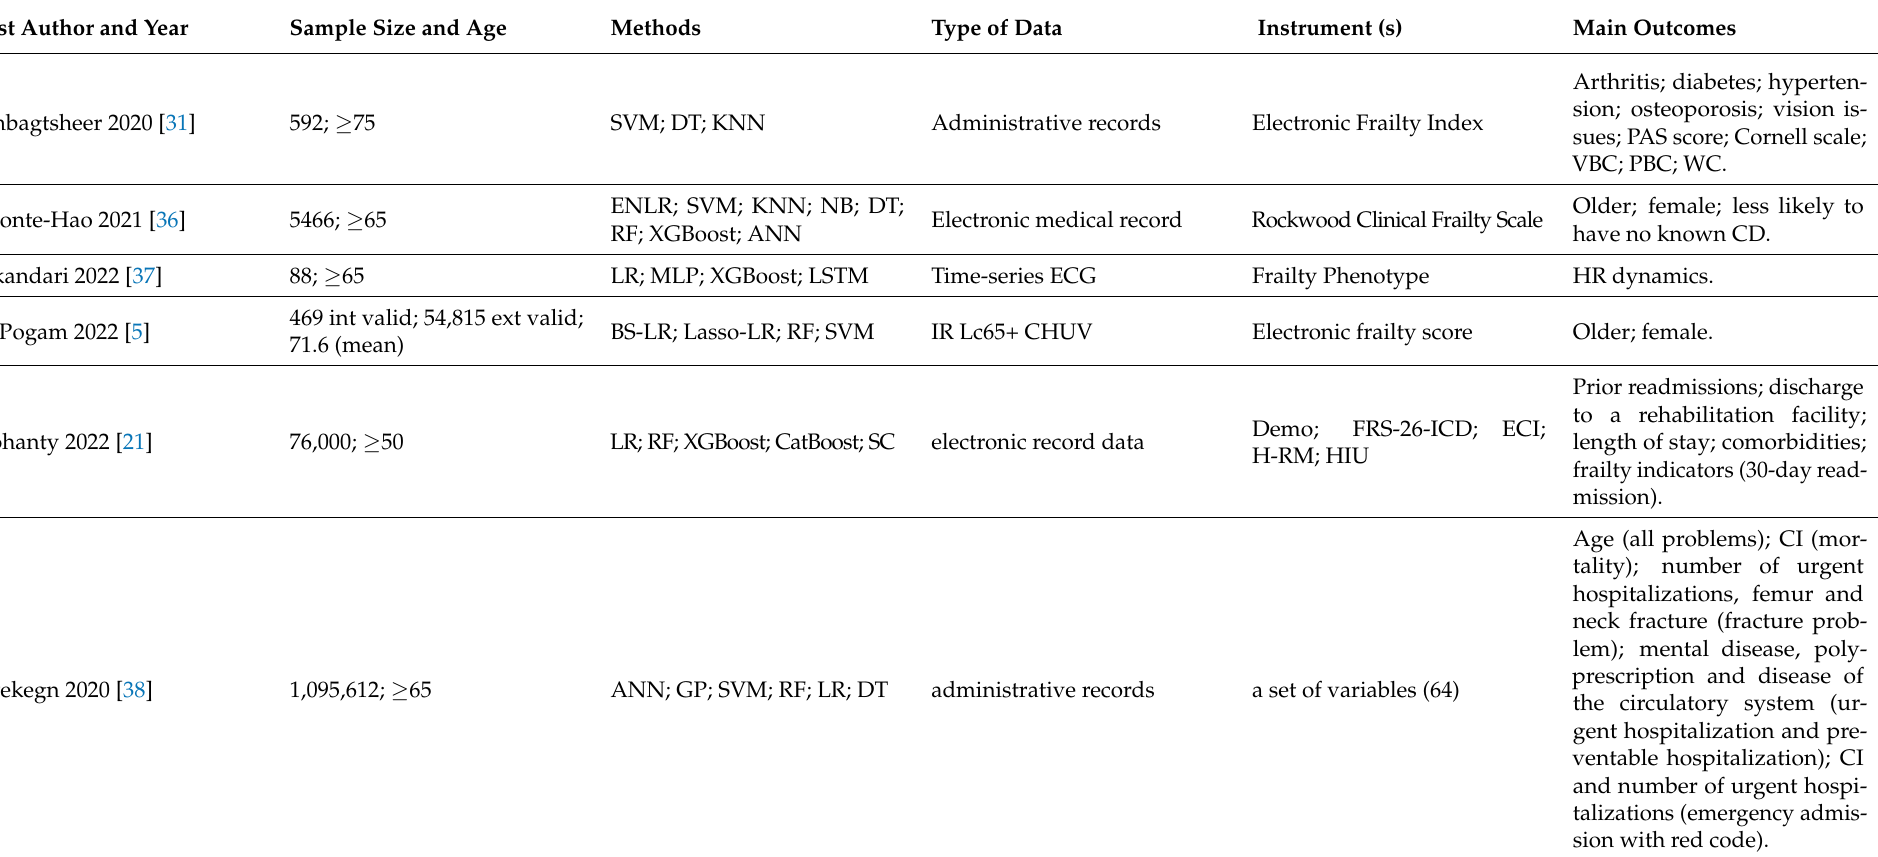
Table 1. Selected studies using the machine learning